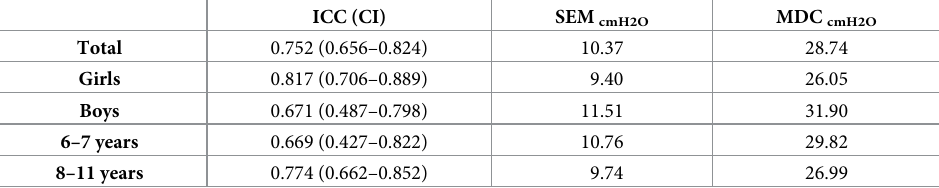
Table 2. Reliability between the highest SNIP and the 1 st acceptable stratified by sex and age groups. ICC